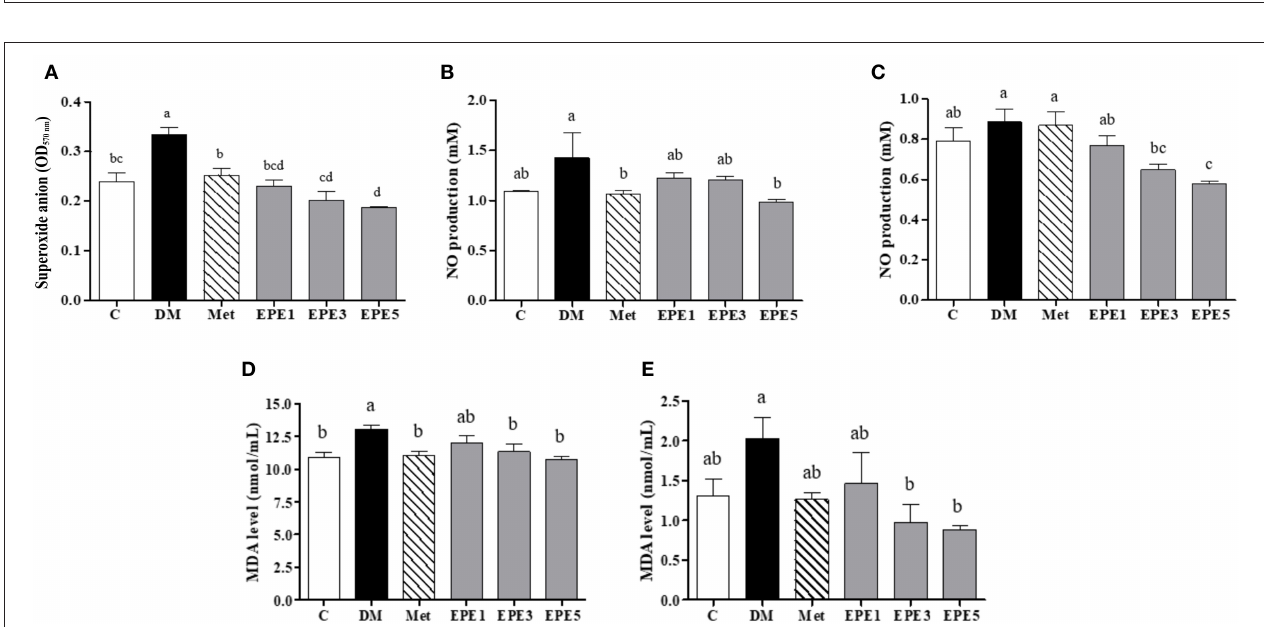
FIGURE 3 | The activities of (A) superoxide dismutase (SOD), (B) catalase, and (C) reduced type glutathione (GSH) of diabetic rats’ sperm after 4 weeks of treatments. Data are shown as the mean ± SEM ( n = 6). The values with different superscript letters (a, b) represent significant differences ( p < 0.05) as analyzed by Duncan’s multiple range test. C, control; DM, diabetes mellitus; Met, metformin; EPE, Echinacea purpurea ethanol extract.